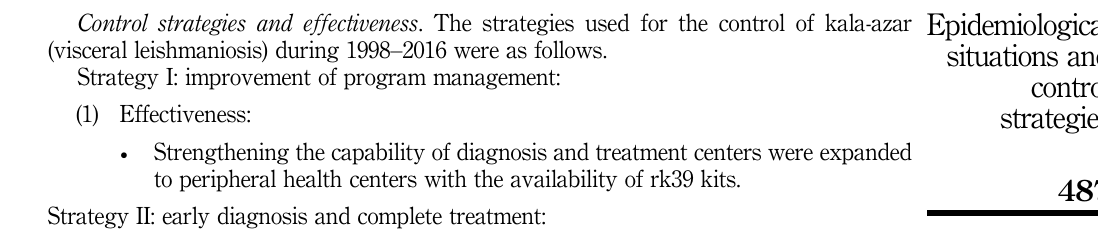
Control strategies and effectiveness . The strategies used for the control of kala-azar (visceral leishmaniosis) during 1998 – 2016 were as